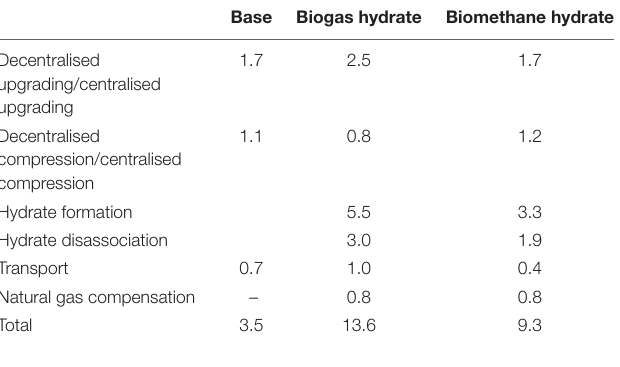
TABLE 2 | Primary energy (PE) inputs (MJ/Nm 3 rawbiogas ) for the three scenarios